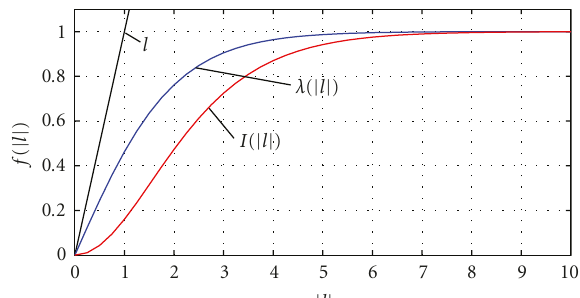
Figure 3: L -value l , soft-bit λ ( l ), and mutual information I ( l ) representations of the LLR plotted as a function of the magnitude | l | of the